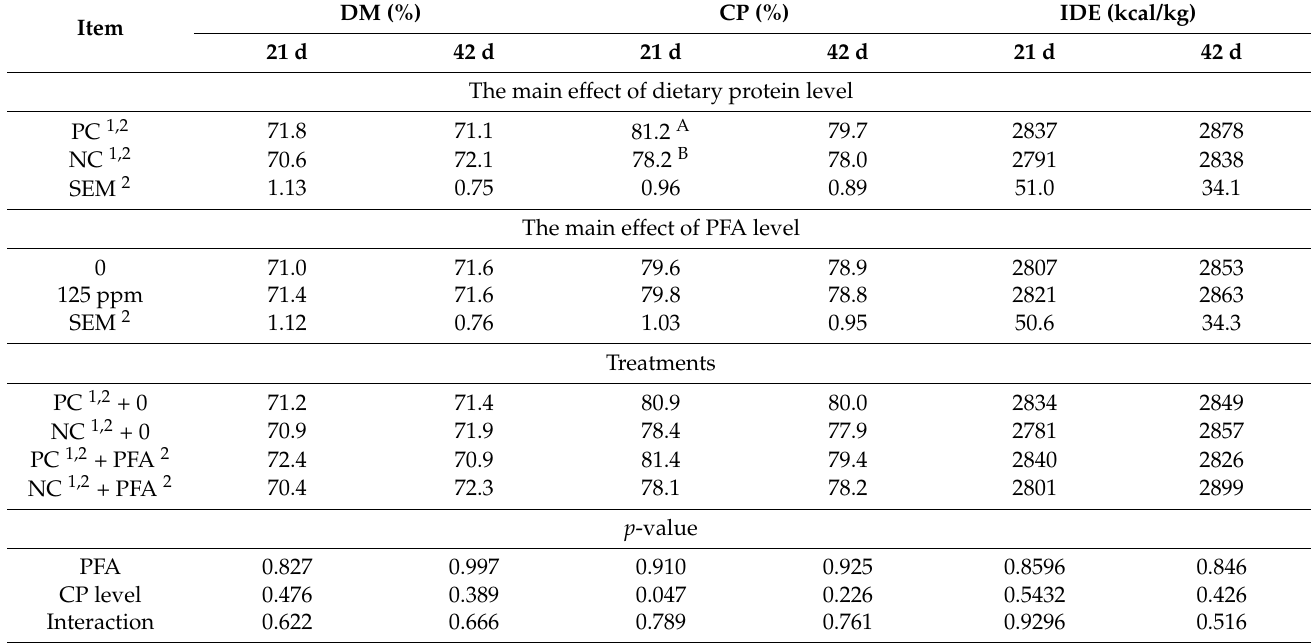
Table 4. Effects of crude protein level and phytogenic feed additive on the nutrient digestibility of